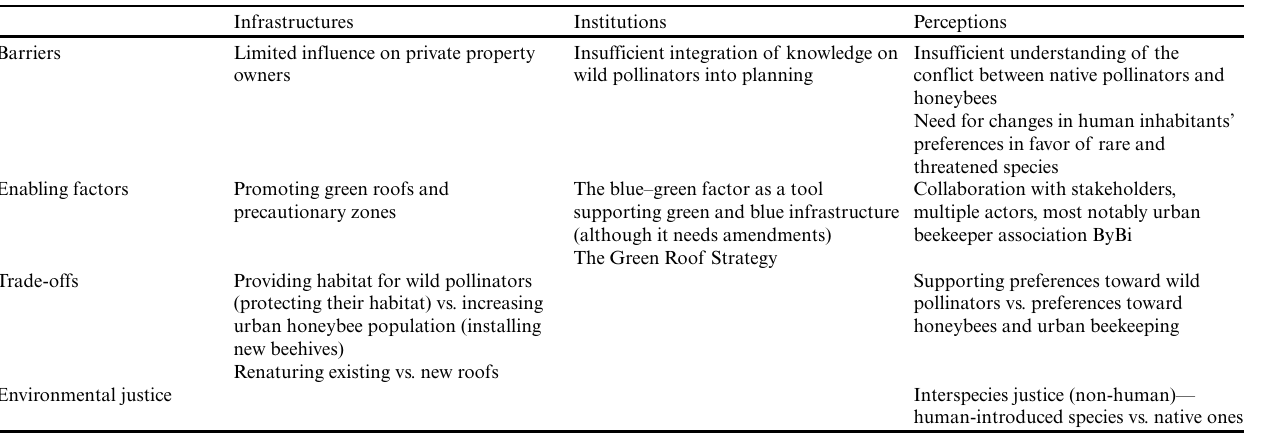
Table 8. ENABLE filters mediating the flow of benefits from GBI to potential beneficiaries translated into an analytical framework for the assessment of GBI-related initiatives—in the case of pollinator conservation initiatives in